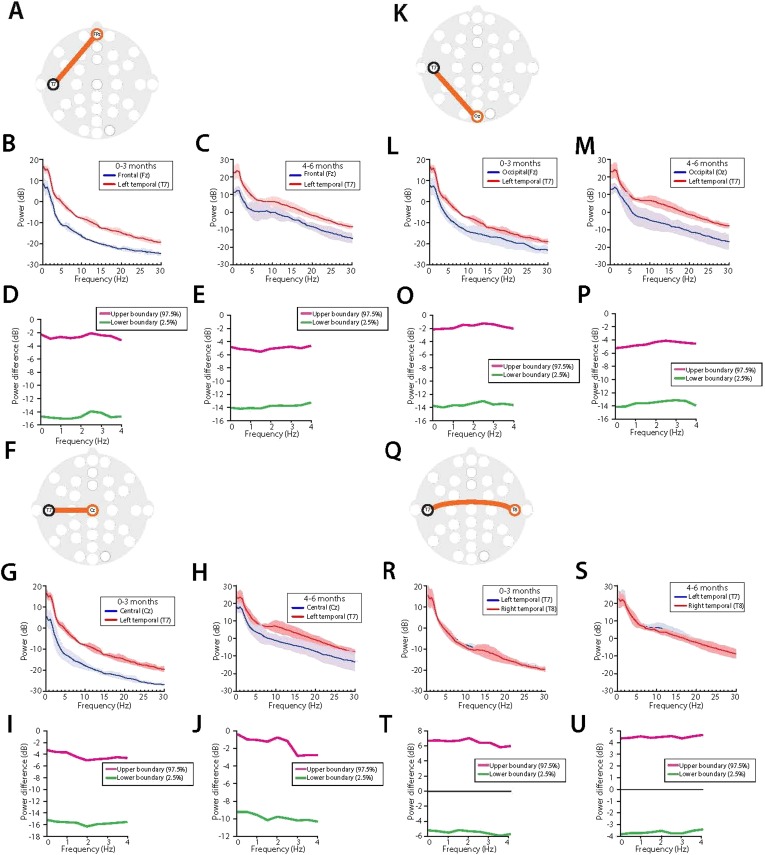
Midline EEG spectral power is lower compared to temporal regions during MOSSA in all infants.Temporal (T7) electrode comparisons are shown for (A-E) vs. frontal midline (FPz); (F-J ), vertex (Cz); (K-P), occipital midline (Oz); and (Q- U) lateral temporal area (T8). For each electrode pair, a schematic of electrode locations ( A, F, K, Q) are shown with the respective analysis of power spectra in infants aged 0-3 months ( B, G, L, R), and 4-6 months (C, H, M, S), and 95% CI, paired bootstrap analysis for infants 0-3 months (D, I, O, T), and 4-6 months of age (E, J, P, U).